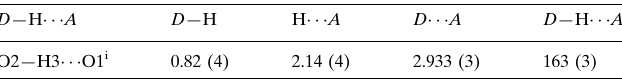
Hydrogen-bond geometry (A˚ , (cid:4)